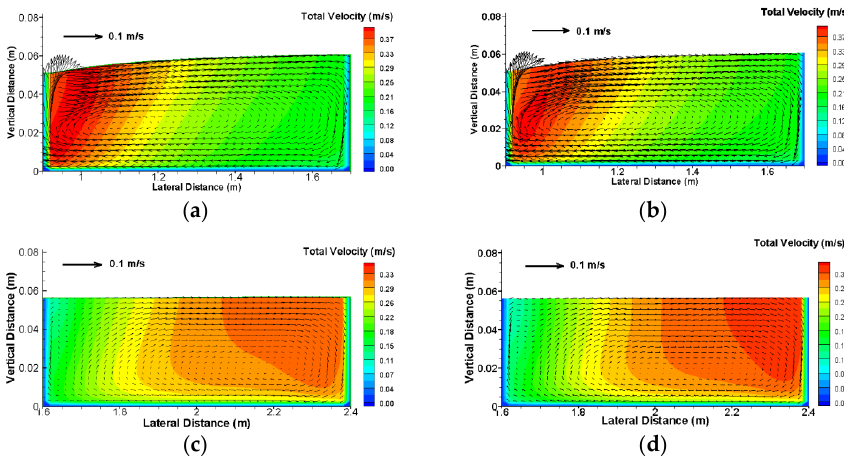
Figure 7. Comparison of predicted secondary flows: SRH-3D on the left and U2RANS on the right. ( a ) SRH-3D at transect 90 °; ( b ) U 2 RANS at transect 90 °; ( c ) SRH-3D at transect 0.1 m after exit ; ( d ) U 2 RANS at transect 0.1 m after exit .